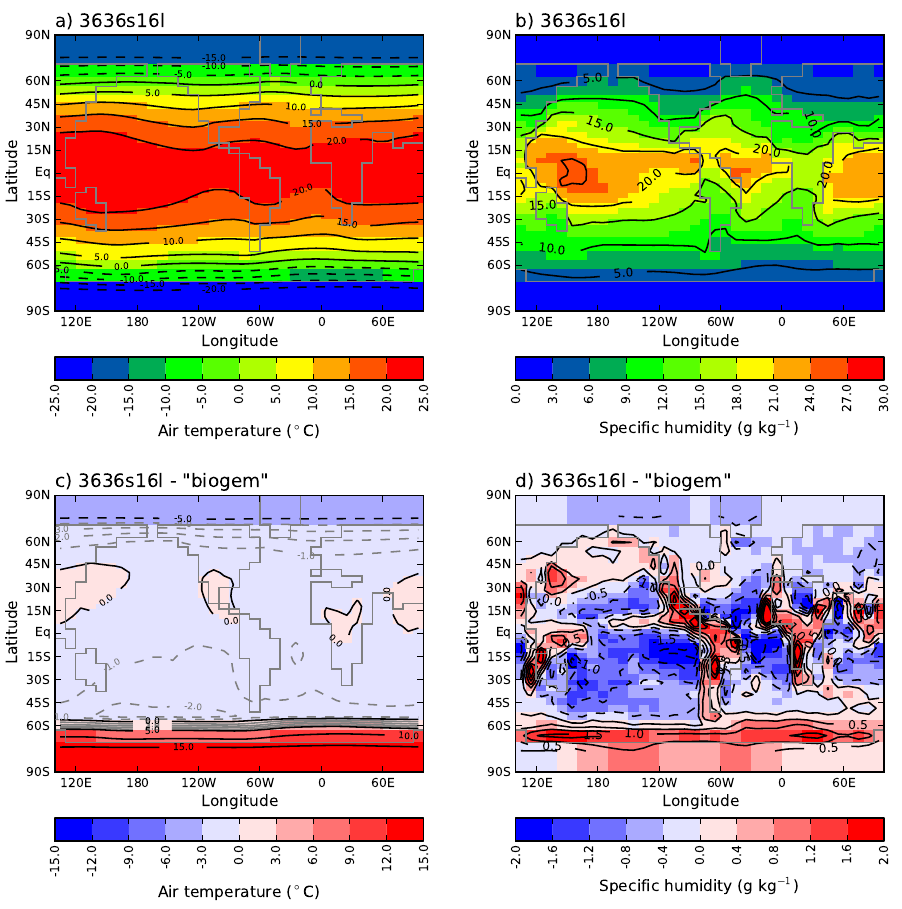
Fig. 7. Annual-mean air temperature ( ◦ C) (a) and specific humidity (g kg − 1 ) (b) for 3636s16l and “biogem” configurations; “3636s16l” minus “biogem” differences for annually-averaged air temperature (c) and specific humidity (d)